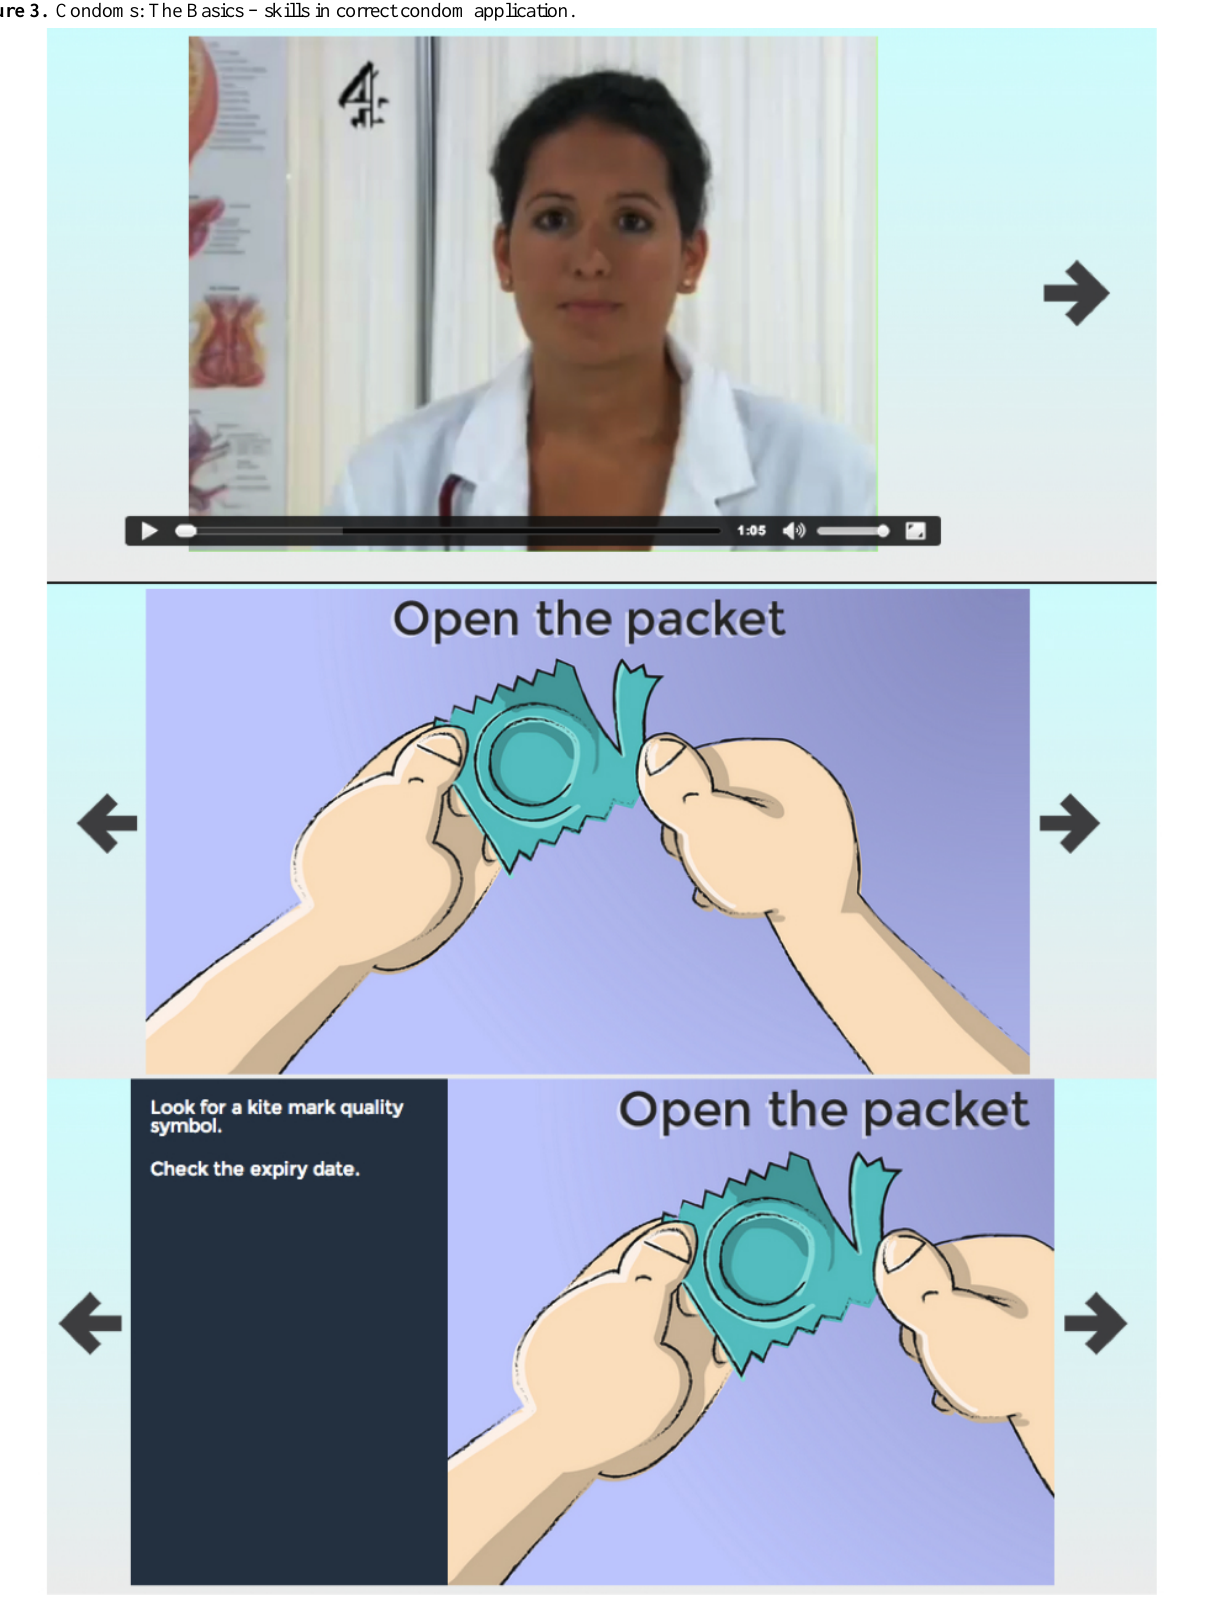
condoms, with poorly fitting or thicker condoms being viewed more negatively. Incorrect condom size was also related to problems such as breakage